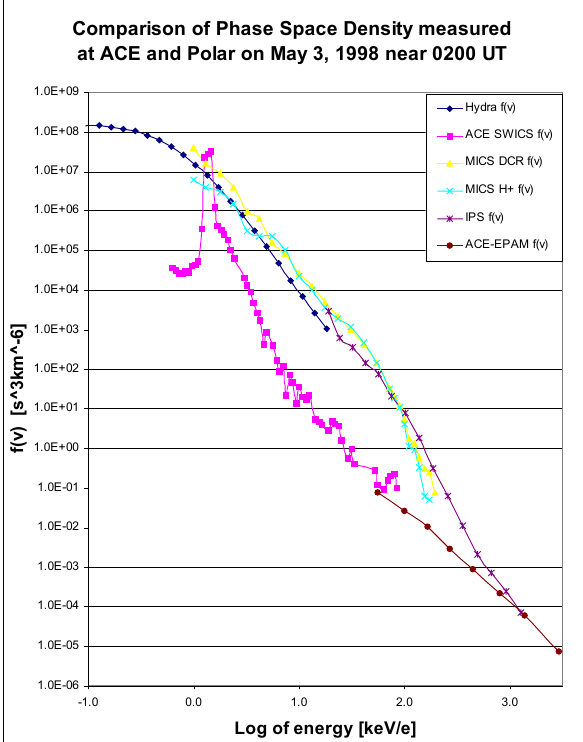
Fig. 11. Same format as Fig. 2 but now the two populations corre- spond to a plasma with an average Fe charge state of +6 recorded just before 14:00UT on 3 May at ACE and just after 14:00UT at